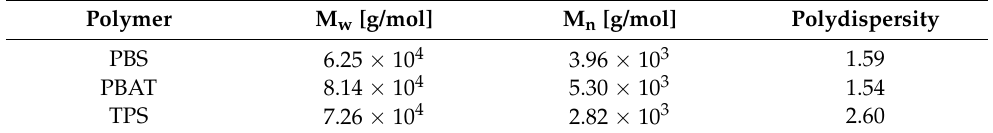
Table 4. GPC analysis of three biopolymers before rheology to determine the molecular weight (M w ), molecular weight distribution (M n ) and polydispersity.